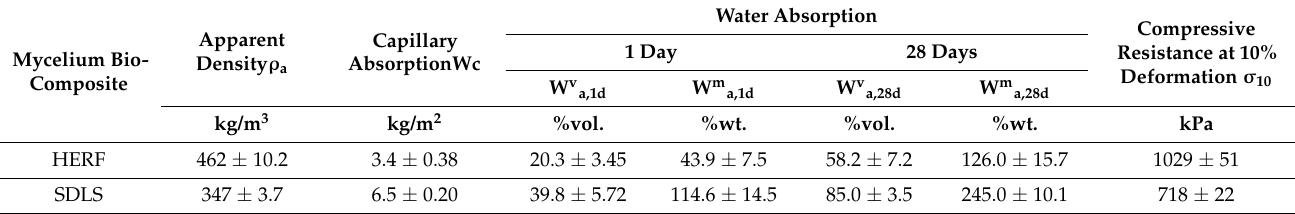
Table 5. Physical and mechanical properties of the mycelium hexane extracted rose flowers (HERF)/ steam distilled lavender straw (SDLS) - based bio - composites. Apparent Mycelium Bio - Density ρ Composite